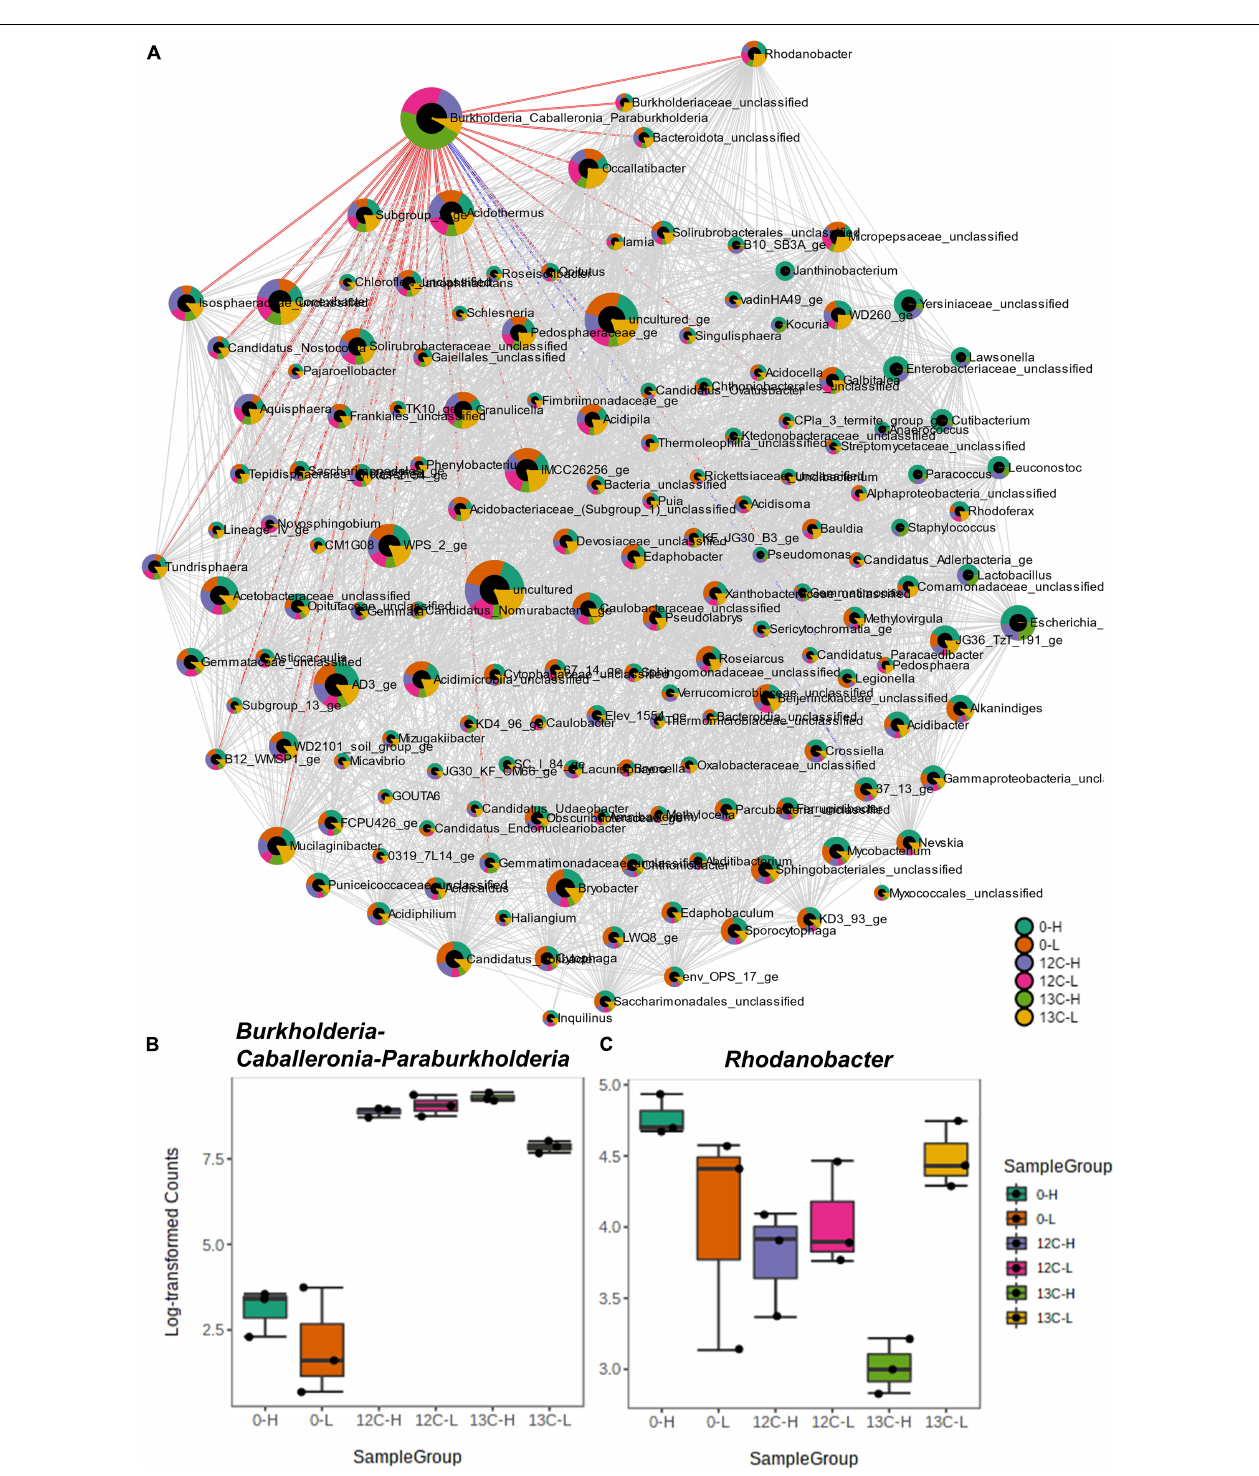
FIGURE 5 | Correlation network analysis of density resolved 16S rRNA sequences retrieved from cryoturbated peat circle sediment incubations (see Figure 1 ) using the SparCC algorithm (A) . Nodes represent genus-level taxa, and red and blue edges represent positive and negative correlations of labeled OTU 1 ( Burkholderia-Caballeronia-Paraburkholderia ). For more details on correlations please refer to Supplementary Table S1 . Node size reflects taxon abundance and colors indicate the relative proportion per sample. The box plots (B,C) show the abundances of Burkholderia-Caballeronia-Paraburkholderia (B) and of one positively correlated taxon ( Rhodanobacter spp.; C ). Sample code: H and L indicate heavy and light fractions, respectively; 0, 13 C-, and 12 C- represent peat circle sediments prior to incubation, 13 C- and 12 C-acetate treatments, respectively.